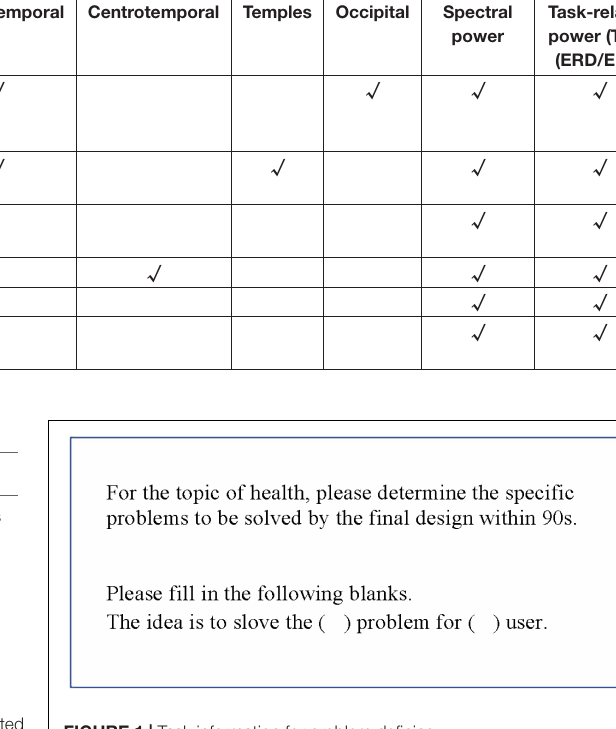
FIGURE 1 | Task information for problem